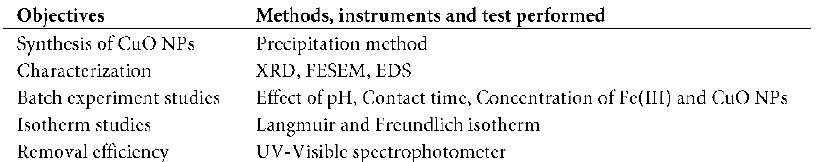
Table 1. Entire test performed in this